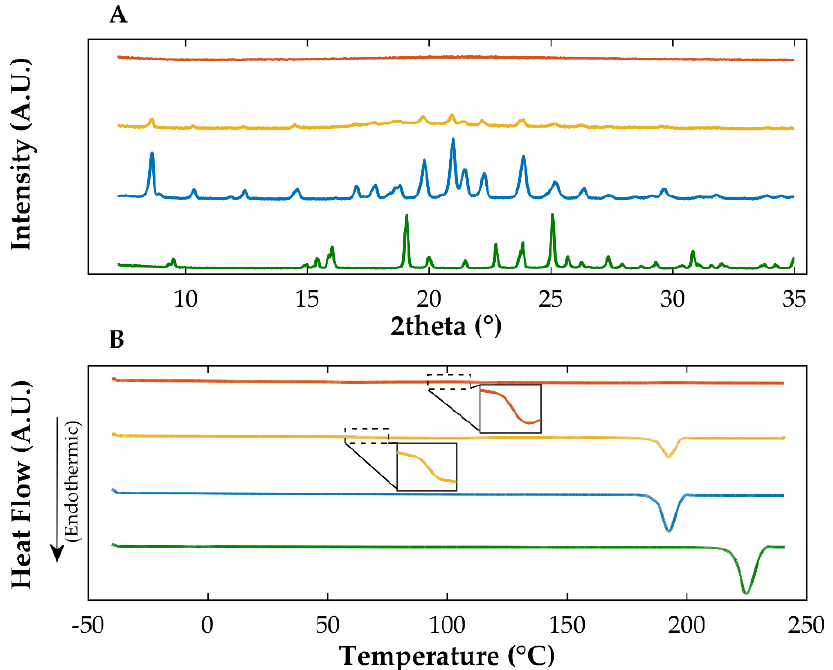
Figure 1. X-ray diffractograms ( A ) and thermograms ( B ) of co-amorphous olanzapine: saccharin (orange), amorphous olanzapine (yellow), crystalline olanzapine (blue) and crystalline saccharin (green). The inserts in thermogram ( B ) are magnifications of the glass transitions observed in the amorphous and co-amorphous entities.